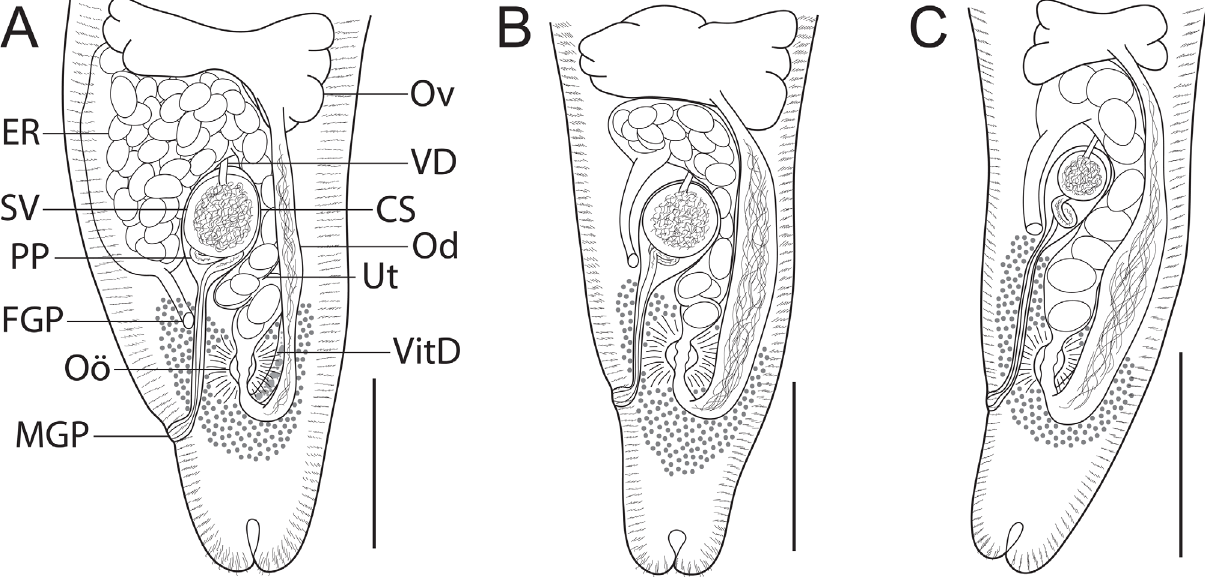
Figure 3. Species of Holocentricola from Great Barrier Reef Holocentridae, terminal genitalia, dorsal views; spines illustrated are ventral. (A) Holocentricola rufus n. sp. ex Sargocentron rubrum from off Heron Island (paratype, QM G239440); (B) Holocentricola exilis n. sp. ex Neoniphon sammara from off Lizard Island (paratype, QM G239119); (C) Holocentricola coronatus n. sp. ex Sargocentron diadema from off Lizard Island (paratype, QM G239126). Abbreviations : CS, cirrus-sac; ER, egg reservoir; FGP, female genital pore; MGP, male genital pore; Od, oviduct; Oö, oötype; Ov, ovary; PP, pars prostatica; SV, seminal vesicle; Ut, uterus; VD, vas deferens; VitD, vitelline duct. Scale-bars: A – C, 100 l